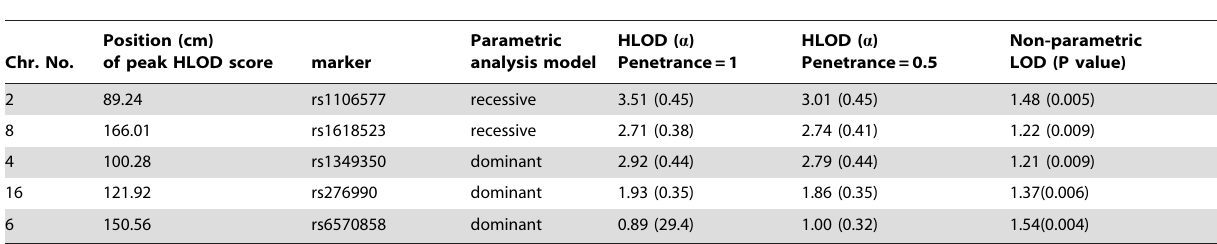
Table 1. Parametric and non-parametric linkage analysis of leprosy families.